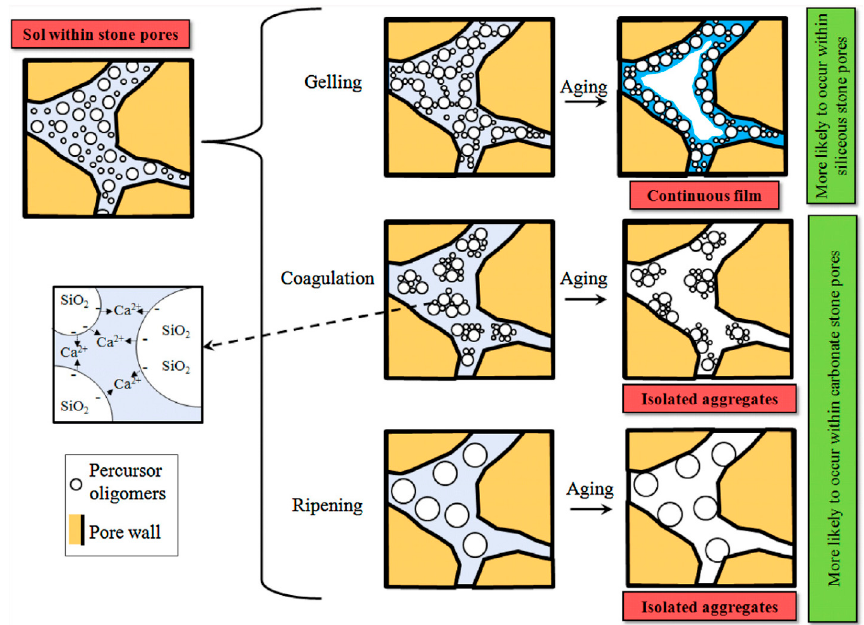
Figure 6. The sol-gel process within the pores of stones that produce silicate gel and xerogel / precipitates. Rounded particles are composed of small siloxanes (Si–O–Si) [7].